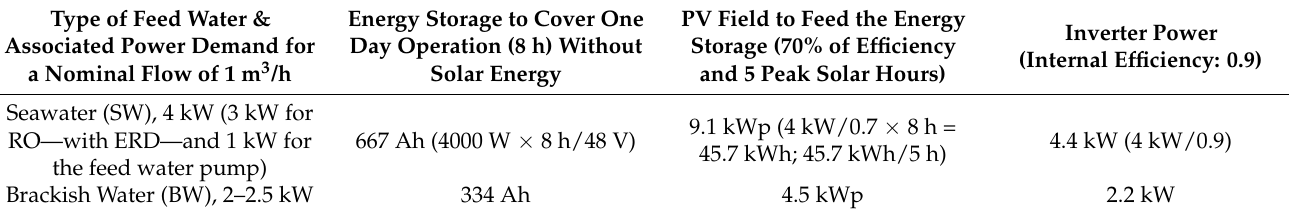
Table 2. Rough estimation of size for the main components of a PV-RO